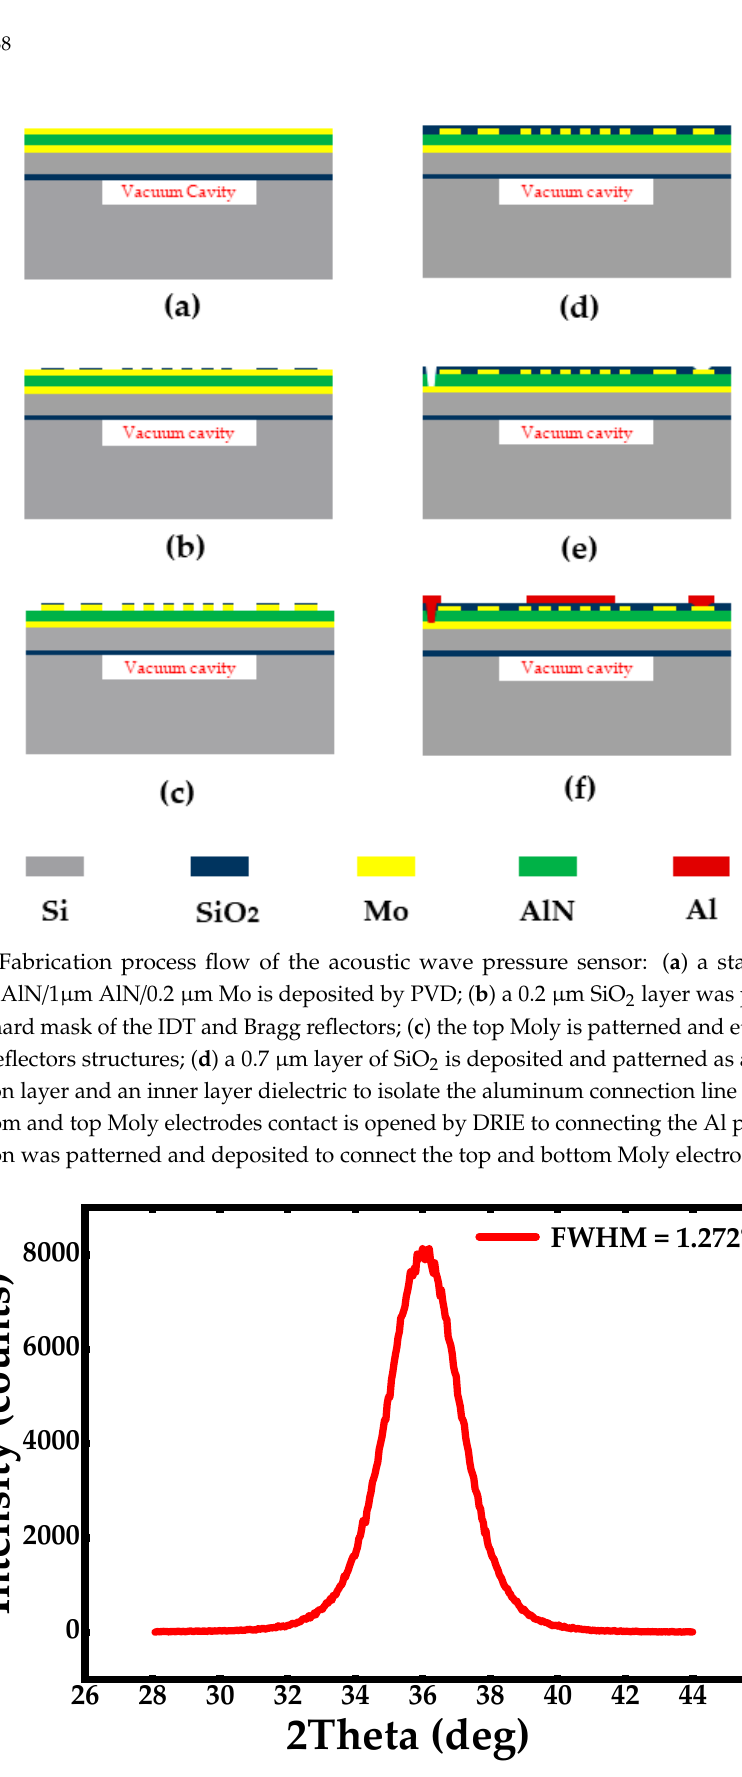
Figure 11. The XRD curve of the AlN film with FWHM = 1.272°.